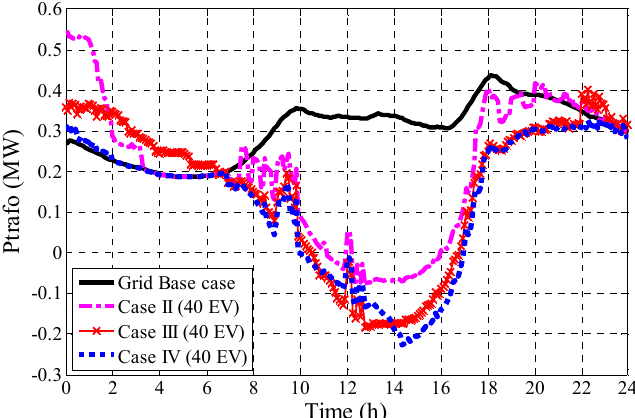
Figure 10. Transformer power profile for different cases.